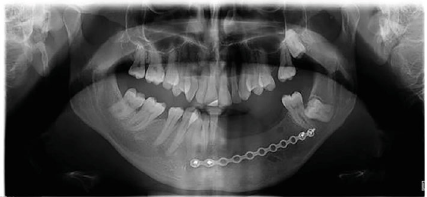
Figure 8: Panoramic view after implant